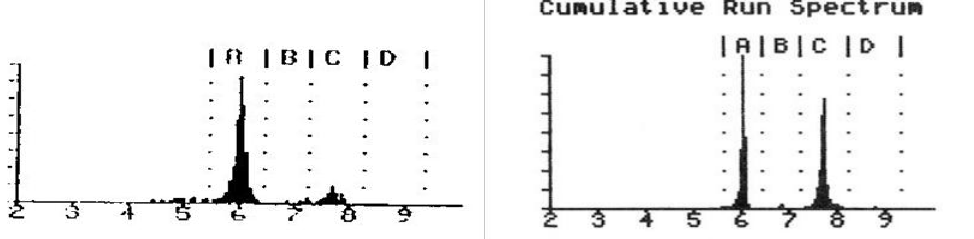
Fig. 4: Alpha energy spectrum for detecting new radon (window A) and old radon